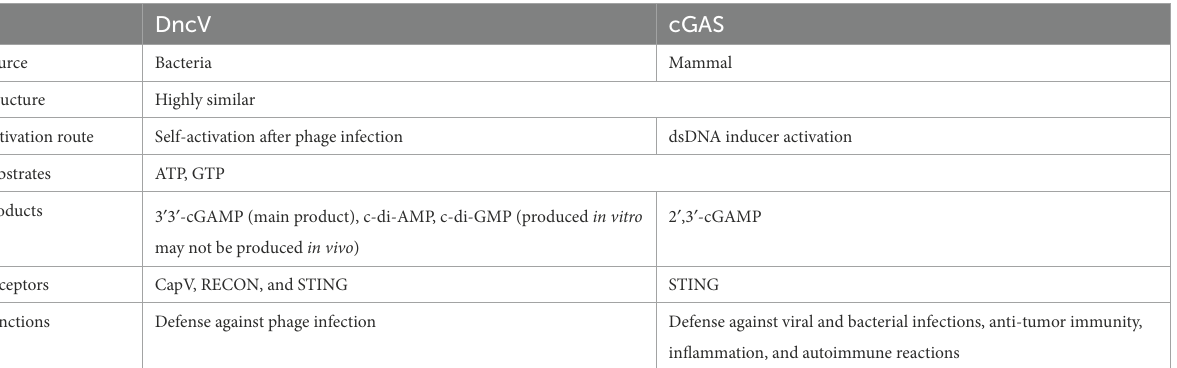
TABLE 1 Comparison between cGAS and